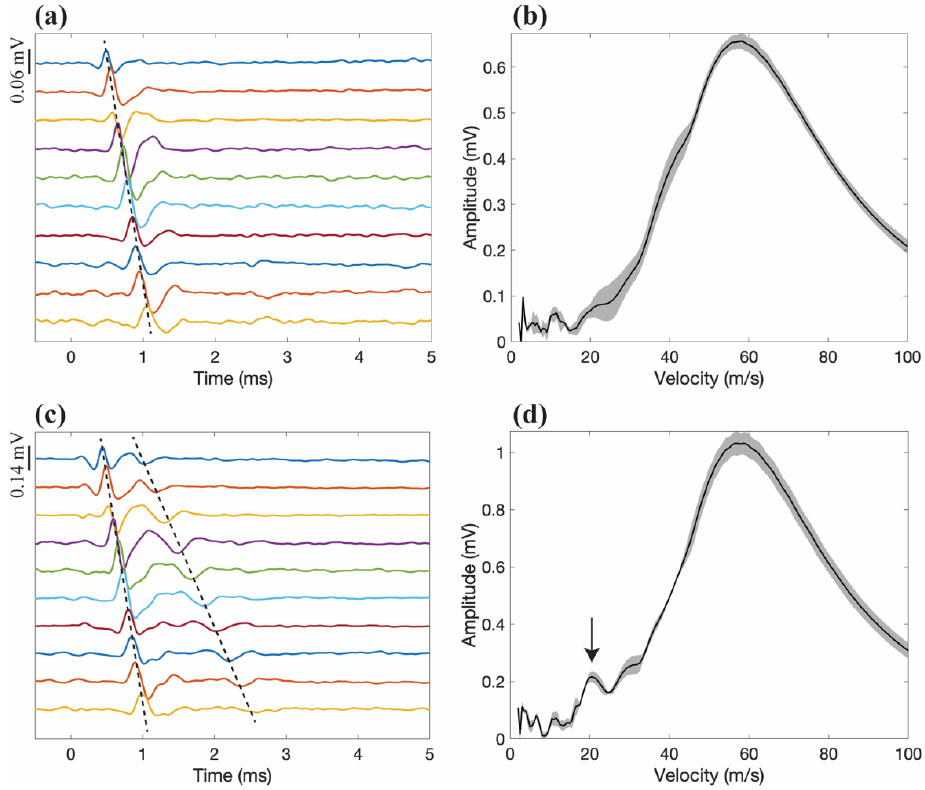
Figure 2. ( a ) Example of an electrically evoked compound action potential (eCAP) response recorded from the cutaneous branch with a stimulus of 350 µ A and a pulse-width of 100 µ s. ( b ) The corresponding intrinsic velocity spectrum (IVS) showing a peak velocity of around 58.5 m/s. ( c ) Re- sponses recorded with a stimulus of 3.5 mA and a pulse duration of 100 μs . ( d ) The corresponding IVS, showing two peak velocities, one with approximately 58.5 m/s and the second with a velocity of roughly 22 m/s. From the IVSs, the shaded area represents the standard deviation of the four repetitions. In the time-domain eCAPs, offsets were artificially created for ease of visualisation. 3.1. Velocity Distribution To characterise the range of velocities supported by the ulnar nerve, the dominant velocities (those for which a distinct peak was observable) were extracted from the IVS for the whole range of stimulation amplitude and levels of pulse duration. All animals dis- played a dominant velocity within the expected range of the Aβ fibres [35–75 m/s]. Figure 3 shows the density estimates for the velocity of the fast fibres (Aβ group) for each animal and stimulation site (i.e., the stimulated branch). The effect of the pulse duration was not considered here, because this effect is expected to be reflected in the threshold of activa- tion and not on the velocity distribution.